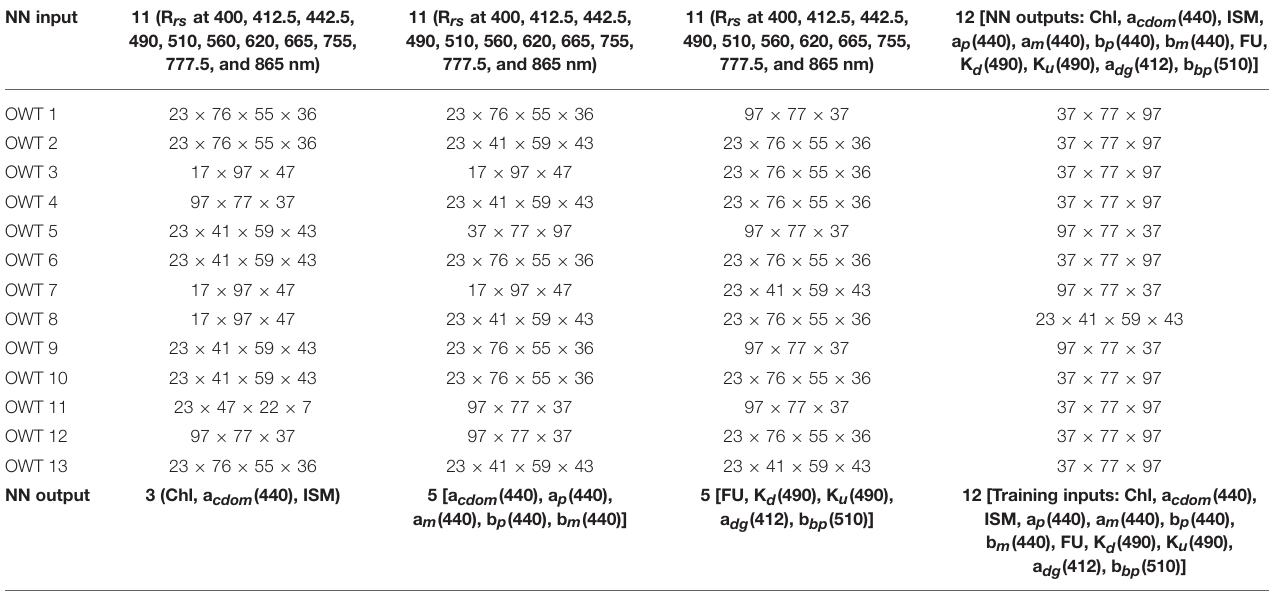
Three sets of NNs deliver selected concentrations, IOPs, AOPs, and the Forel-Ule color code. A fourth set of NNs (right column) estimates the uncertainties of the NN outputs. Inputs and outputs for the NNs are log 10 (X + 0.001), where X stands for R rs or an ocean color product (this applies not for FU).